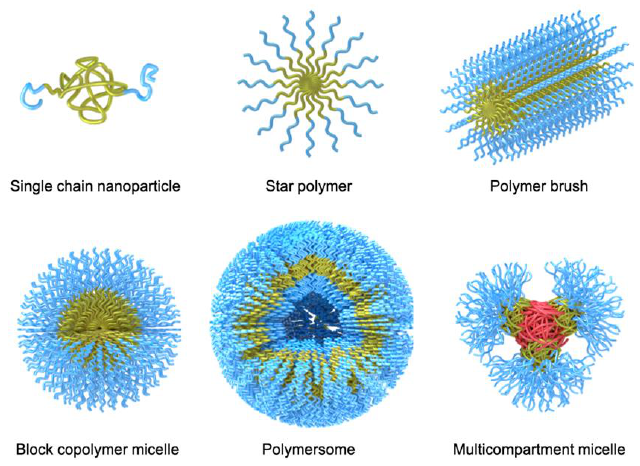
Figure 2. Selection of frequently used polymer compartments for catalysis.